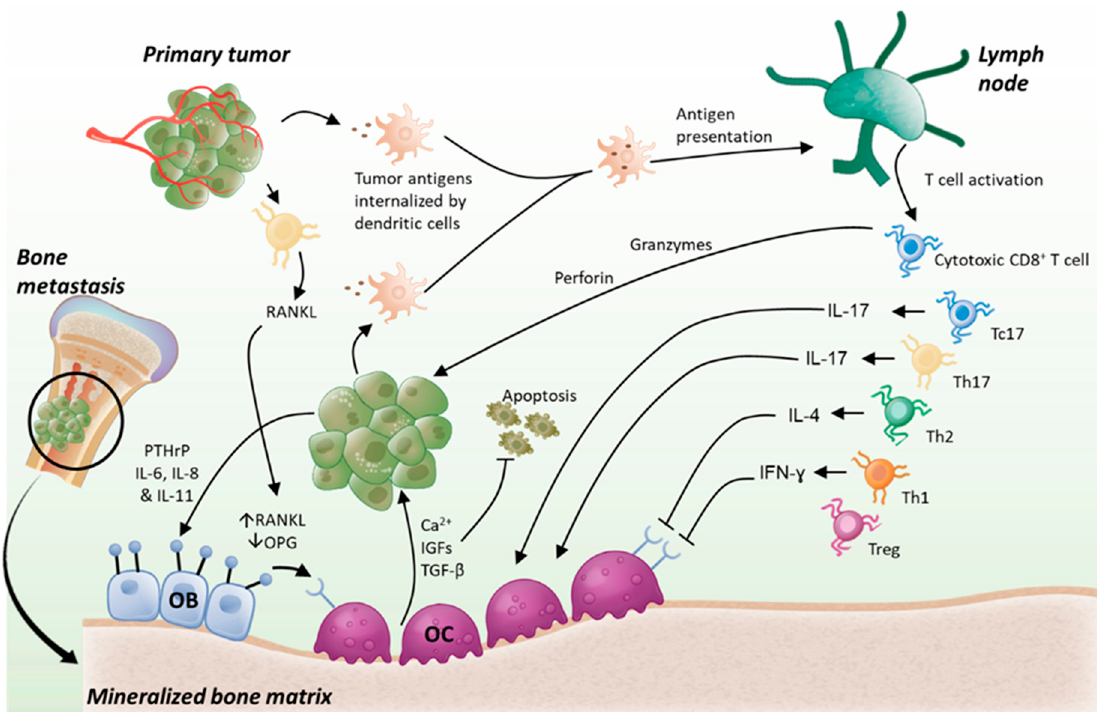
Figure 3. The role of T cells in bone metastasis. Antigens from dead cancer cells are taken up by dendritic cells to be presented to T cells in lymphoid organs such as the lymph nodes. Primed T cells can then home to the tumor site. While cytotoxic CD8 + T cells can induce the apoptosis of cancer cells, local factors, such as bone-derived TGF- β or bone marrow Tregs inhibit this cytotoxic response. TGF- β is released due to the bone resorption by osteoclasts (OC) caused by cancer cells cytokines (i.e., PTHrP, IL-6, IL-8, or IL-11), and the subsequent expression of RANKL by osteoblasts (OB). T cells that produce IL-17 (Th17 or Tc17) or RANKL (Th17) can also increase bone resorption and support the development of bone metastases, while IFN- γ and IL-4 derived from Th1 and Th2, respectively, can inhibit osteoclast formation and potentially limit bone metastases.